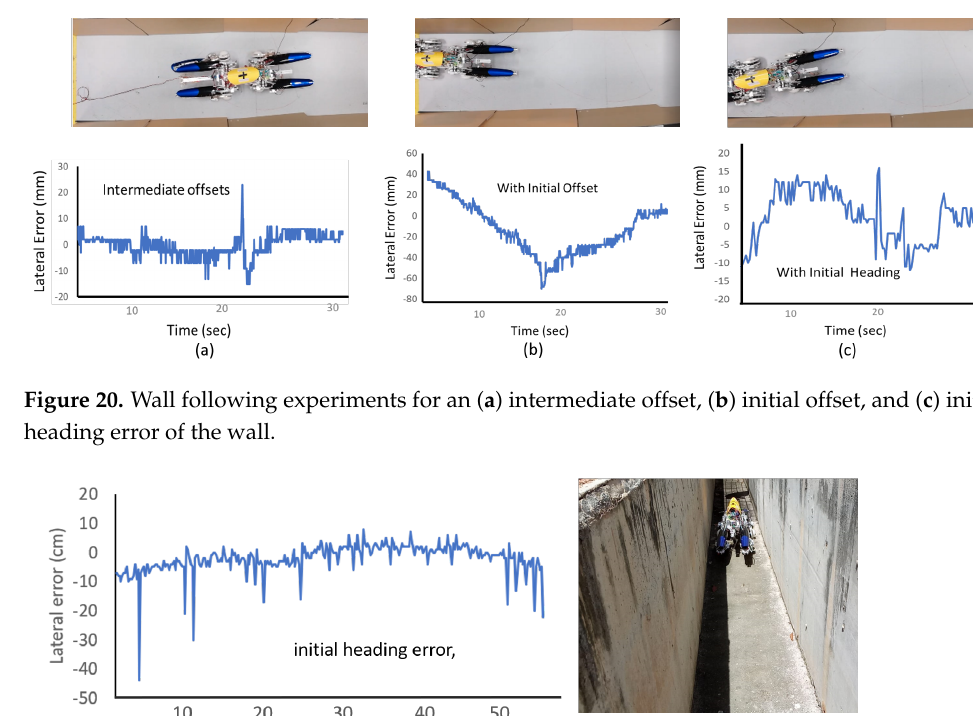
Figure 19. The platform’s pose with the trunk maintaining a horizontal position and leg height adjustment on ( a , b ) an inclined plane, ( c , d ) during a level shift.